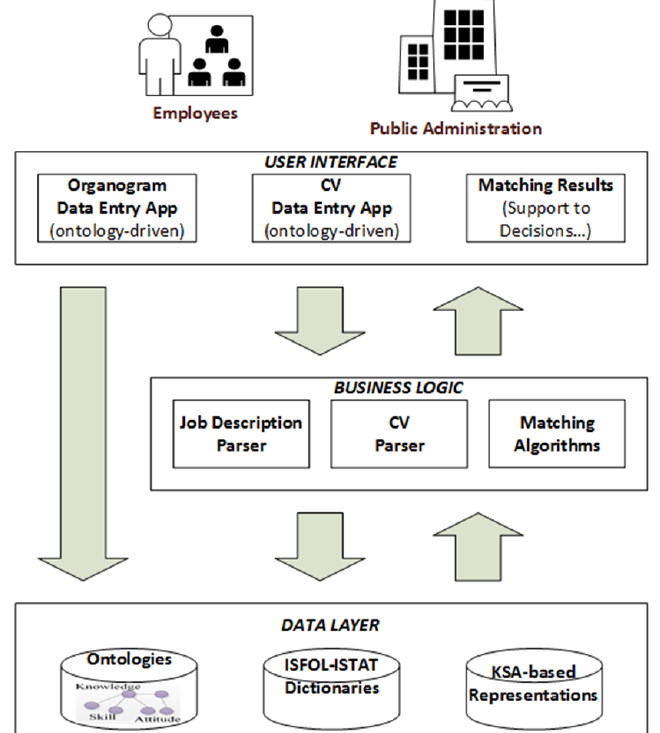
Figure 2. An architectural view of the